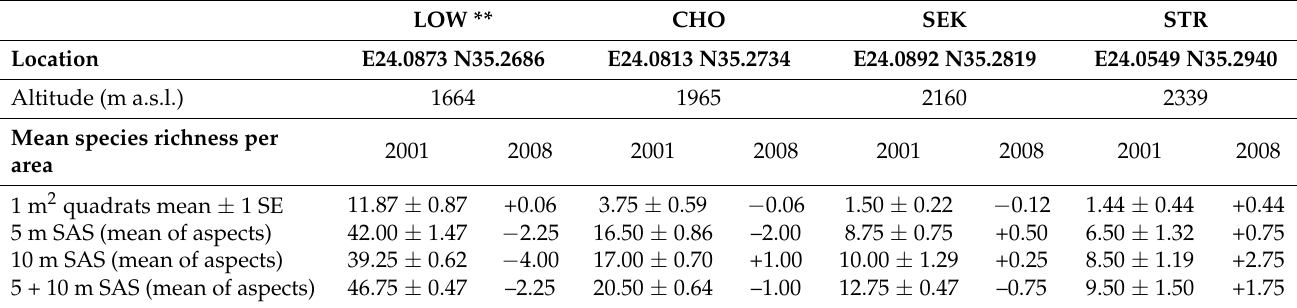
Table 1. Summary information for the four summits: Location, altitude, and size of the SAS *, mean species richness in 2001 and the mean difference between 2008 and 2001. LOW ** CHO SEK STR Location E24.0873 N35.2686 E24.0813 N35.2734 E24.0892 N35.2819 E24.0549 N35.2940 Altitude (m a.s.l.)